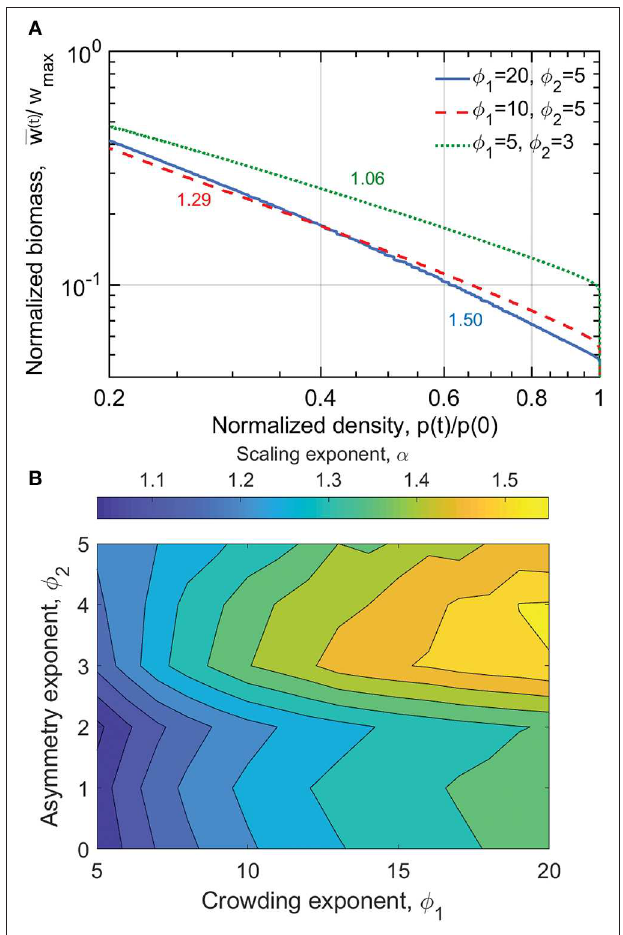
FIGURE 6 | (A) Modeled normalized biomass per individual as a function of normalized plant density for the three competition scenarios indicated in the legend; time progresses from right to left as plants grow and density decreases. The corresponding scaling exponents α are written next to the plotted lines. (B) Variation in α driven by different competition scenarios. Model parameters are found in Table S3